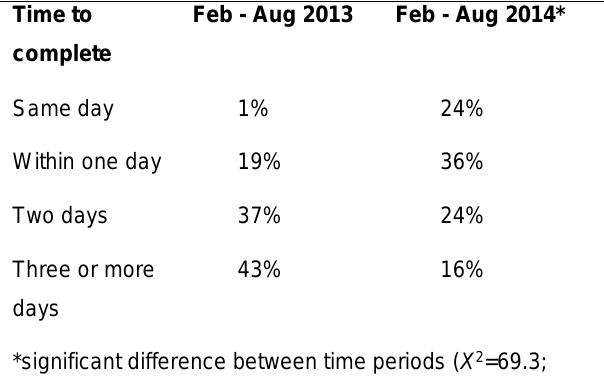
Table 4. Time Taken to Complete the Home Visit from